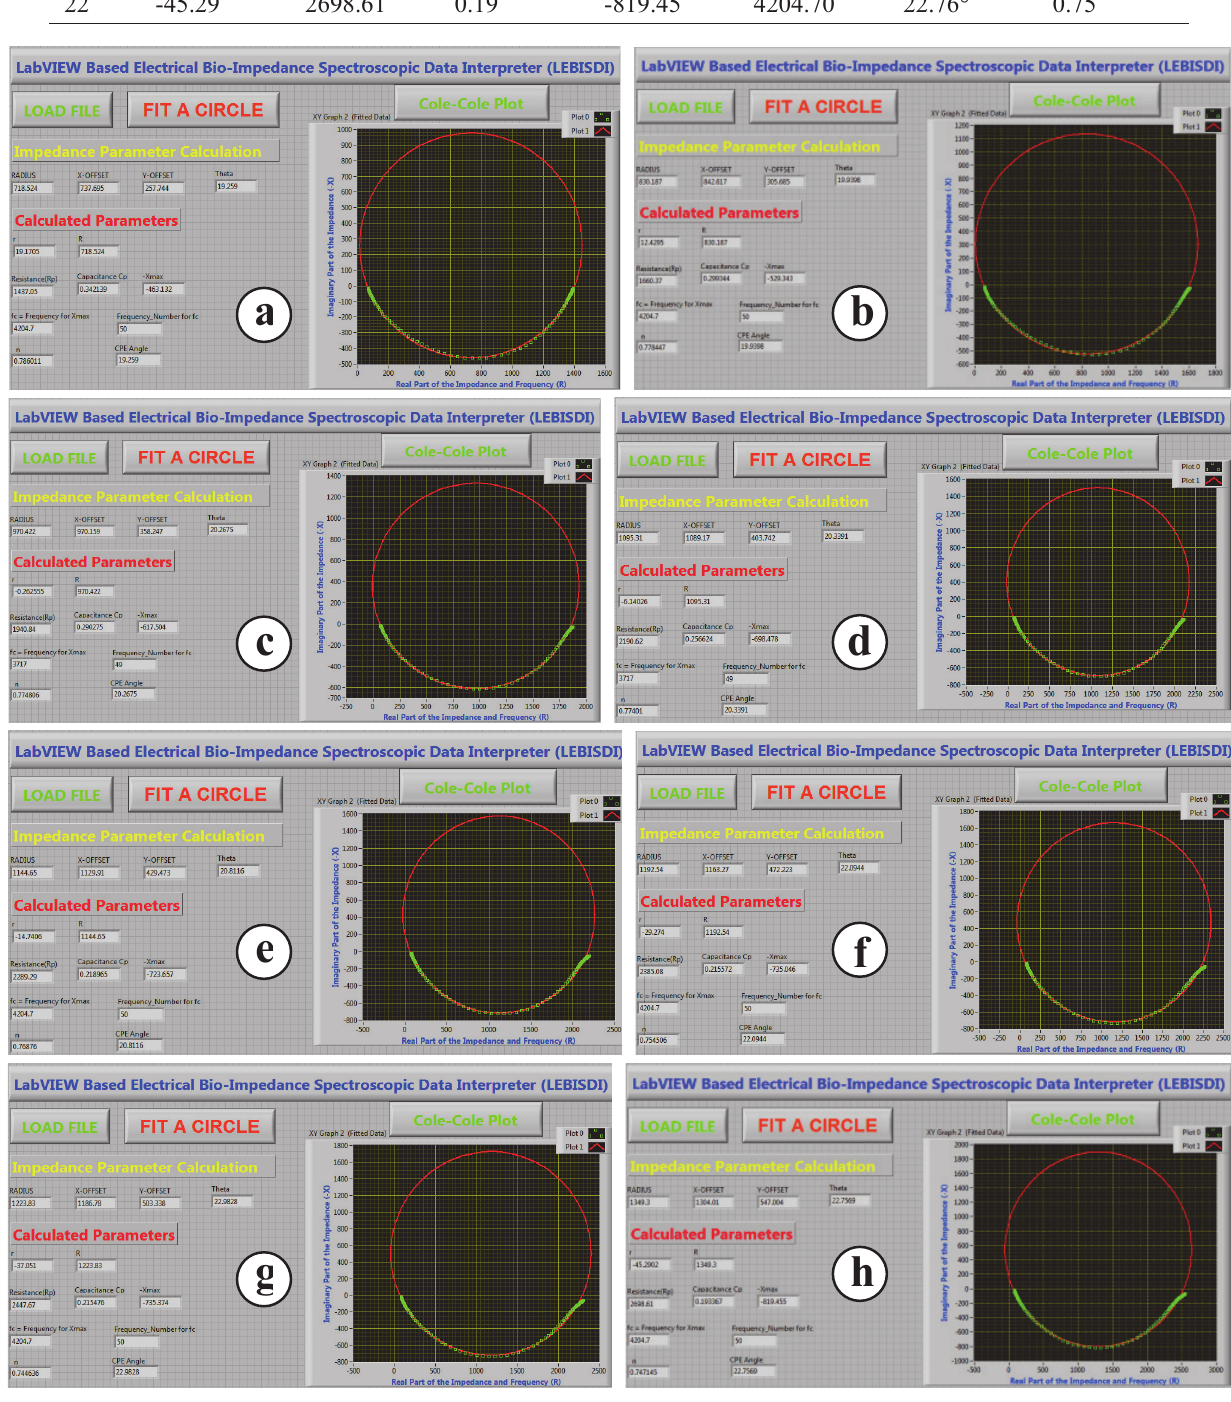
Fig.19: Impedance plots obtained for a cucumber over a 22-day storage period using a LEBISDI to show the variation in the impedance parameters for naturally stored vegetables: (a) day 1, (b) day 4, (c) day 7, (d) day 10, (e) day 13, (f) day 16, (g) day 19 and (h) day